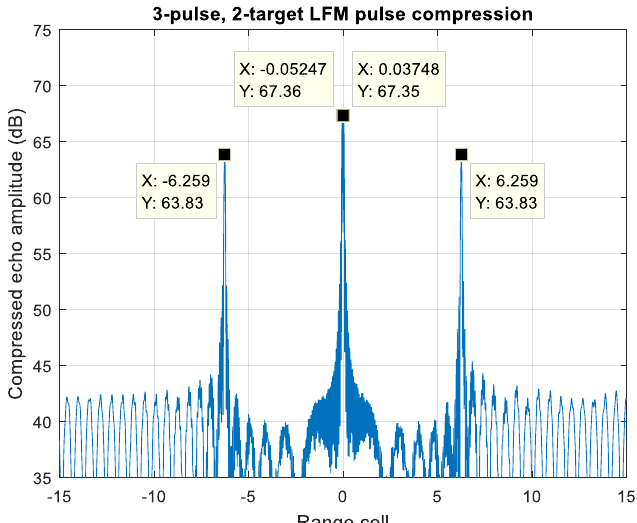
Figure 23. Pulse compressed echo of two overlapped targets. Target-one is Near-zero-Doppler, while target-two velocity is at 15 Mach.